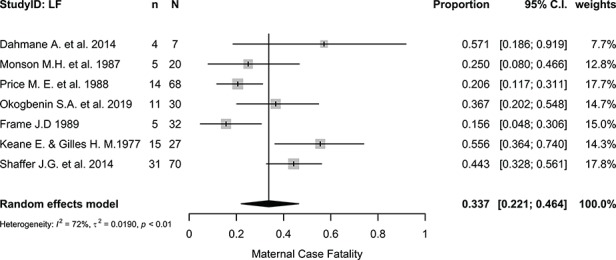
Proportional meta-analysis forest plot of studies reporting maternal death for Lassa virus infection in pregnancy. I2, Higgins statistic, τ2, tau squared, p, p-value associated with Cochran's Q for heterogeneity; LF, Lassa fever; n, number of maternal deaths; N, total number of pregnant women included in the analysis.